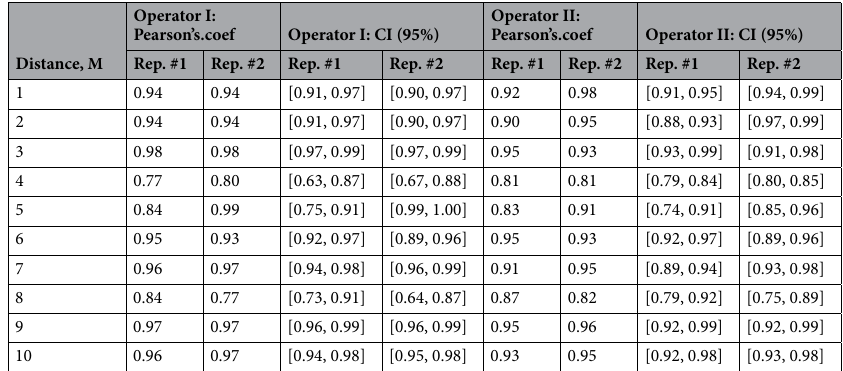
Table 4. Correlation metrics between automatically and manually computed anthropometric